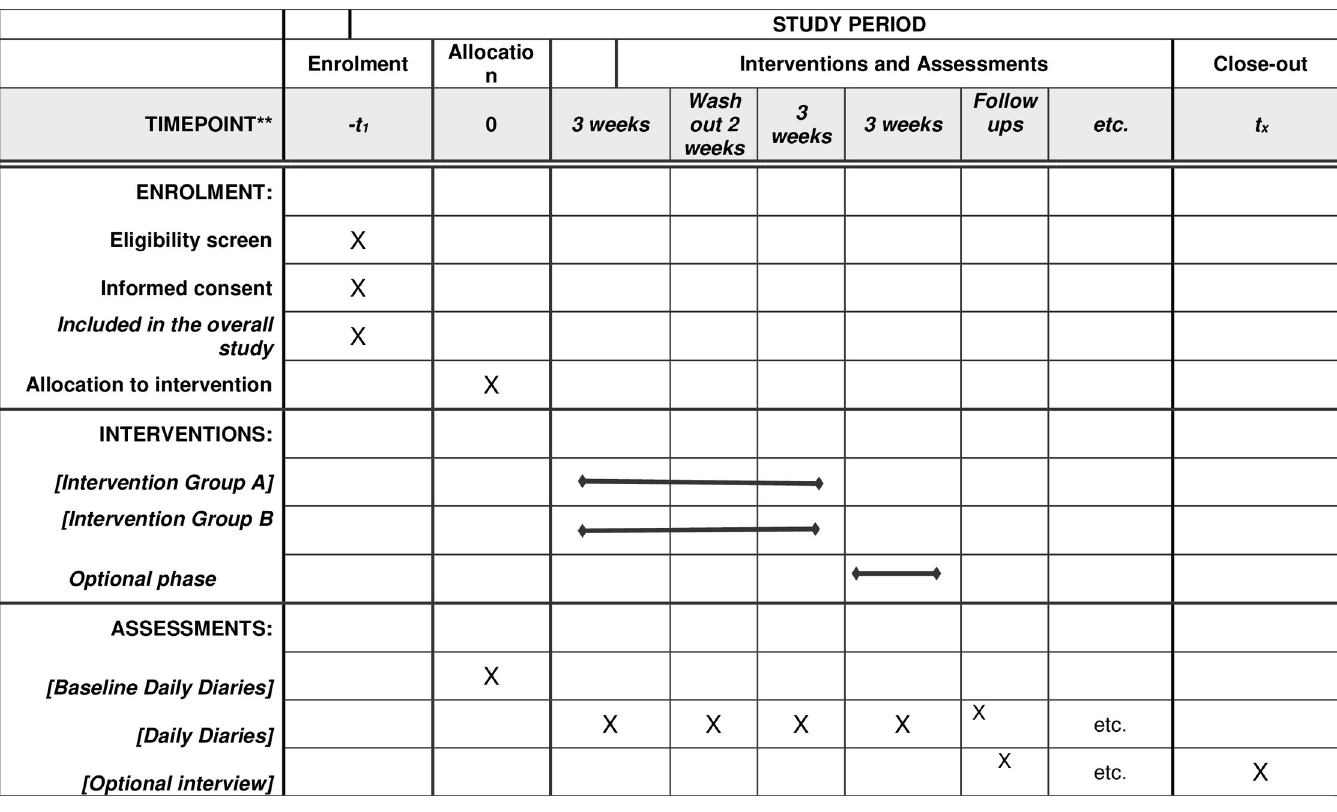
Fig 1. Schedule of enrolment, interventions, and